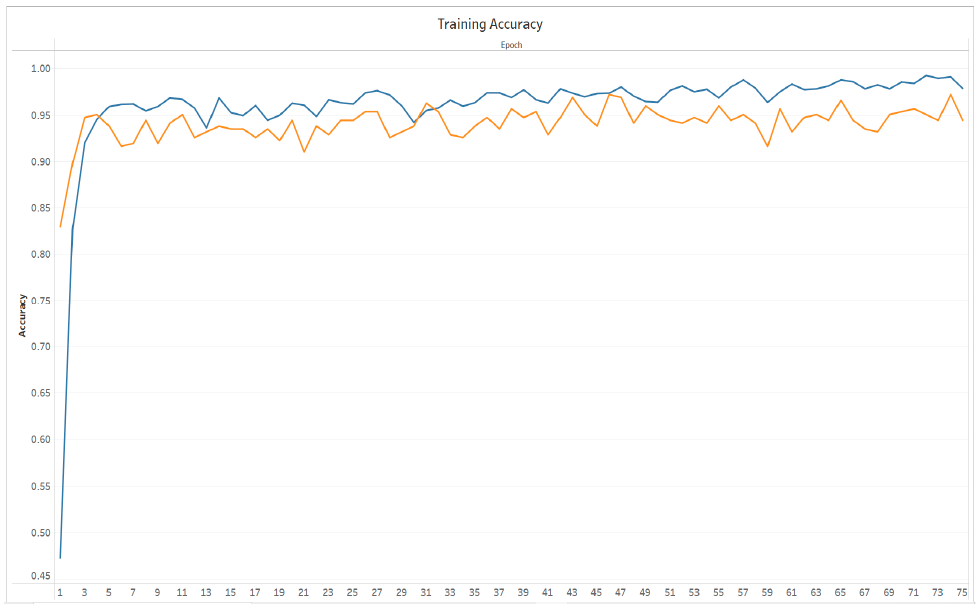
Figure 34. Training accuracy curve.